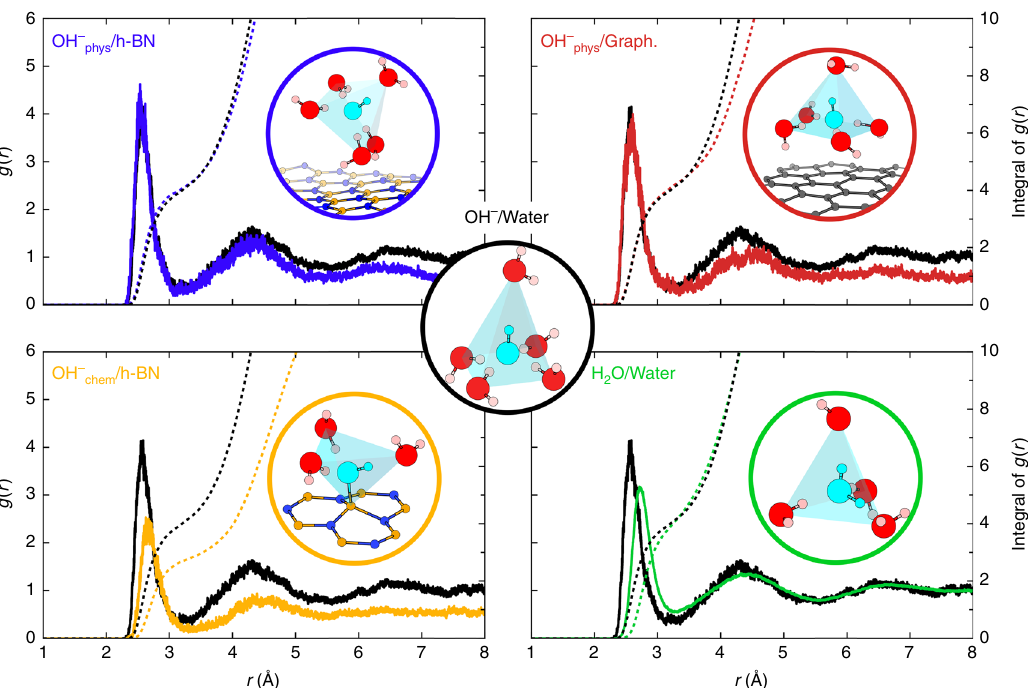
Fig. 4 Radial distribution functions from unbiased trajectories. Radial distribution functions of oxygen atoms around the free hydroxide oxygen O* in different environments: bulk water (black), chemisorbed on h-BN (orange), physisorbed on h-BN (blue) and physisorbed on graphene (red). The g ( r ) of a H 2 O molecule in bulk water is shown in green. The integrals of the g ( r ) are displayed as dotted line in the corresponding colour. Solvation geometries of the different con fi gurations are shown within circles of the associated colour: square pyramid for the anion in bulk water (black) or physisorbed on h-BN (blue) or on graphene (red), tetrahedron for a chemisorbed OH − on h-BN (orange) or for a bulk water molecule